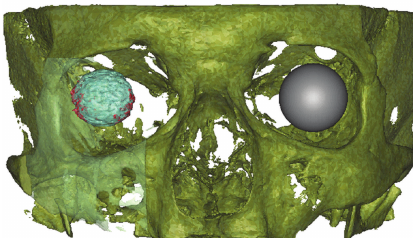
Figure 11: Frontal view of volume rendering of the scanned volume with the orbital implant and the contralateral corpus vitreum. The orbital implant volume within the factory implant diameter (light blue) and beyond the factory implant diameter (red). The contralateral orbit is represented as a gray sphere (patient ID 1.27).